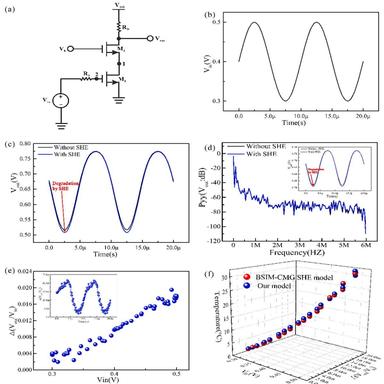
(a) Amplifier schematic; (b) Input power signal Vin; (c) the output voltage Vout of the amplifier with and without SHE; (d) Pyy of the amplifier with and without SHE; (e) The variation of Vout Vin corresponding to different Vin in the simulation of the amplifier with or without SHE; (f) Comparison between the calculation results of the BSIM-CMG SHE model and the model proposed in this article.